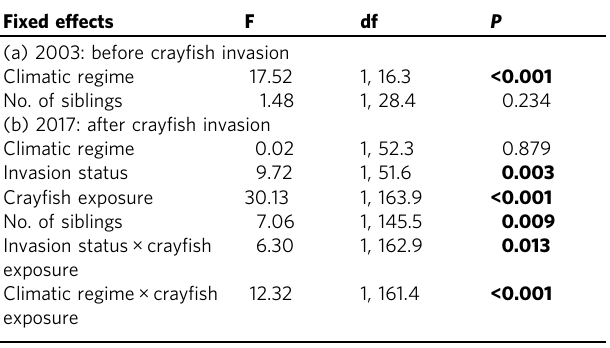
Table 1 Factors determining development time of agile frogs, before (a) and after (b) cray fi sh invasion: results of linear mixed models (two-sided F